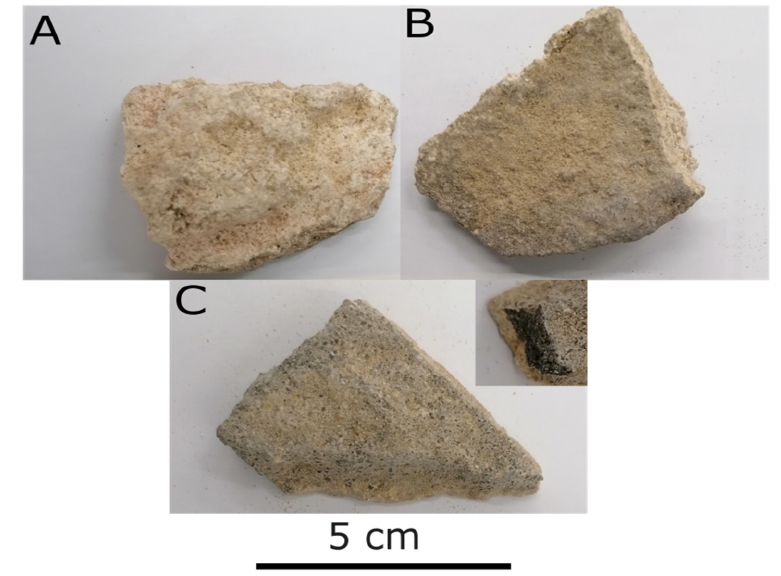
Figure 11. ( A , B ) Construction stones (casing and bedrock). ( C ) Coarse and fine rendering mortars.